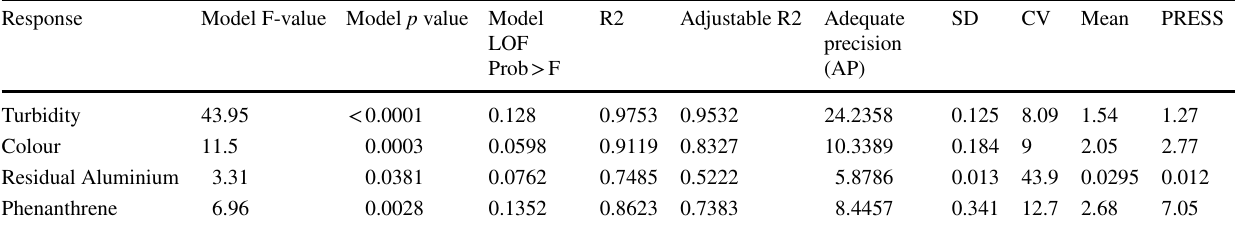
Table 5 ANOVA results for response parameters in RSM jar test